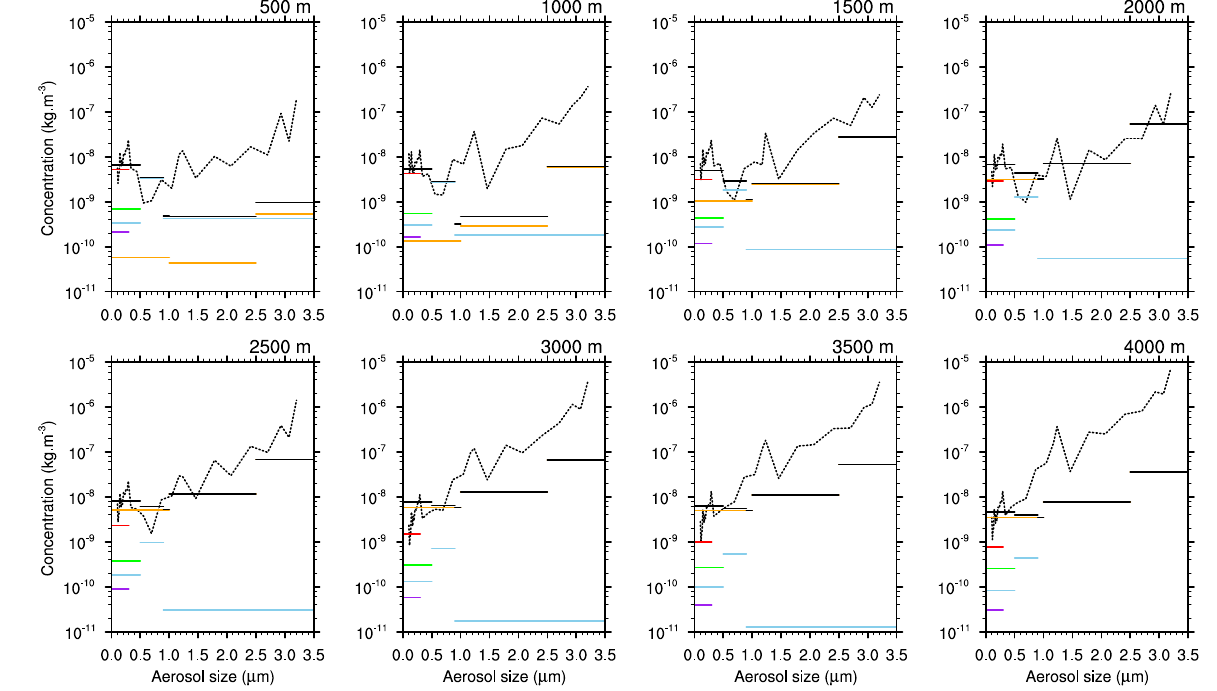
Figure 7. Dust particle size distribution observed by the PCASP instrument onboard ATR42 (flight 22) on 29 June at 08:00UTC (dashed black lines), the dust refractive index has been adjusted (1.53–0.002i). Full coloured lines indicate the aerosol concentration for each aerosol bin of CNRM-RCSM5 (red is sulphate, blue is sea salt, orange is dust, green is organic matter and purple is black carbon), while full black lines indicate the total concentration (kgm − 3 ).